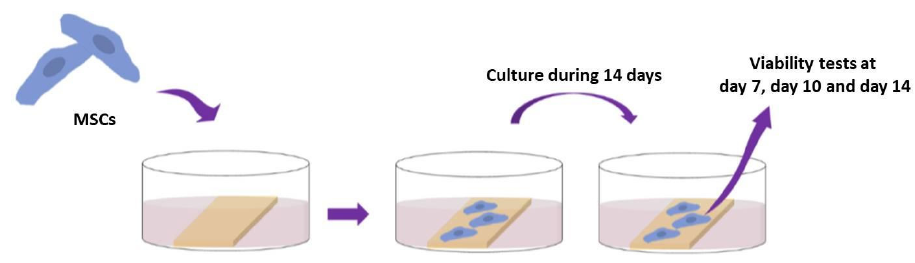
Figure 4. Cell viability test performed at day 7, day 10 and day